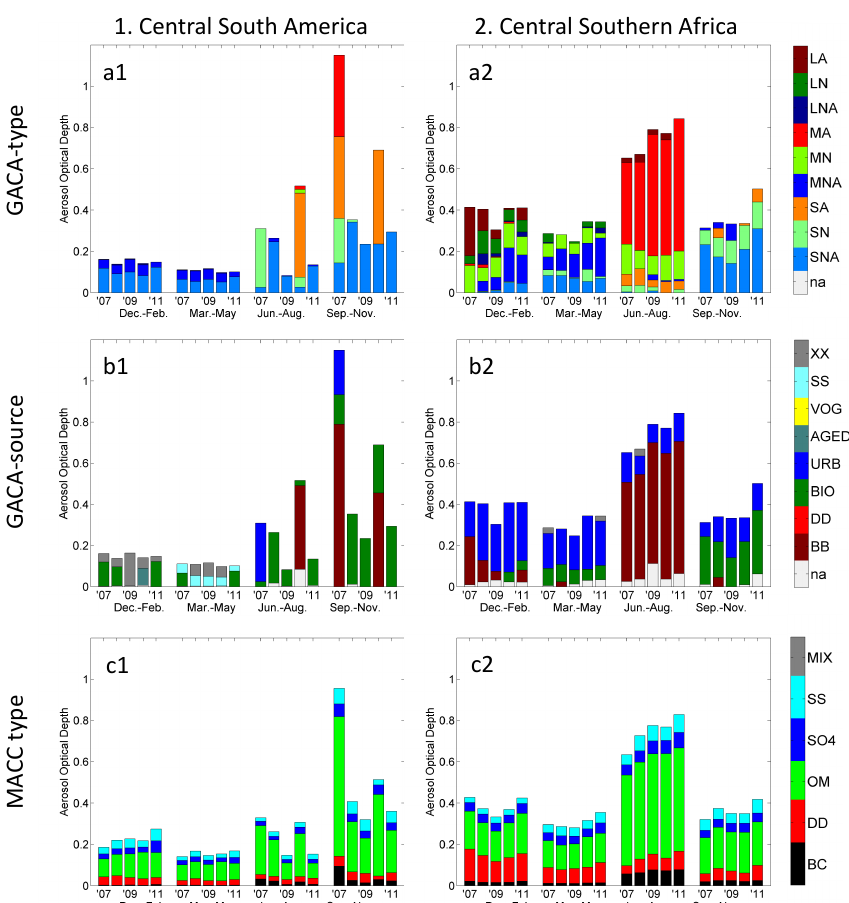
Figure 10. Seasonal cycles of global aerosol type and source according to GACA and MACC for 5 ◦ × 5 ◦ regions in central South America (10–15 ◦ S, 60–65 ◦ W) and central southern Africa (0–5 ◦ S, 15–20 ◦ E). Data are grouped into four seasons and separated by year. Panels (a1) and (a2) mean AOD contribution of each aerosol type; (b1) and (b2) mean AOD contribution of aerosol source (determined from each aerosol type); (c1) and (c2) mean AOD contribution of aerosol types from MACC. Abbreviations are explained in Table